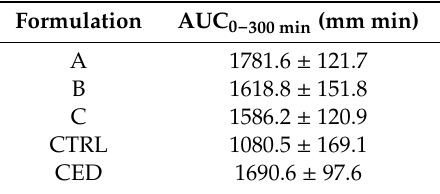
Table 8. Area under ‘the change in pupil diameter versus time’ curve (AUC 0–300 min